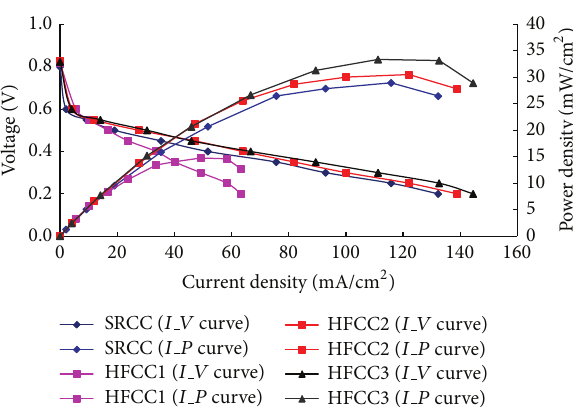
Figure 4: Schematic drawing of Nyquist plot and circuit diagram for a simple fuel cell impedance model. Figure 5: Performance comparison of the DMFC with different current